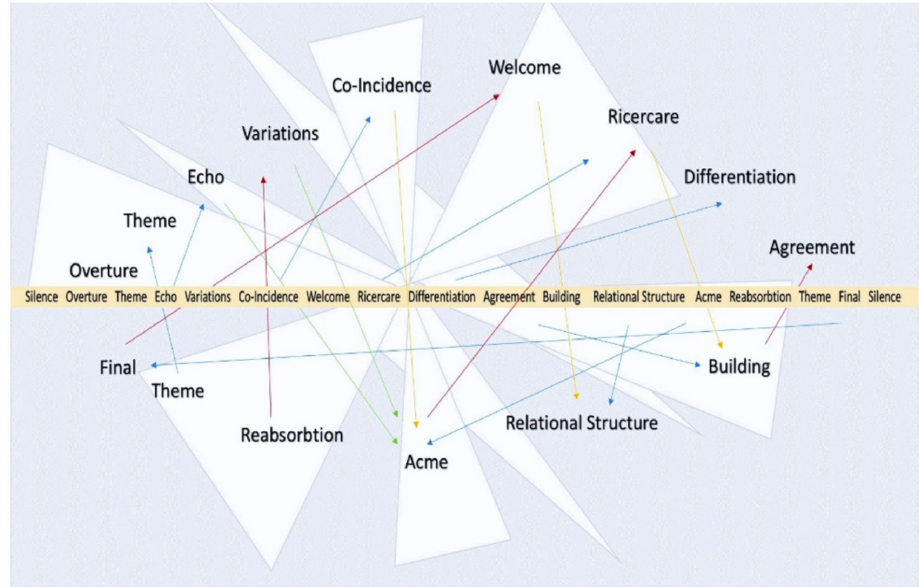
Figure 2. Here the same sequence is indicated as in the previous picture. It is always located in the center but follows a horizontal plane: a different way of showing the same sequence and its reflections that correspond to different levels of perception. The reflections wander in parallel, upwards as well as downwards, ideally suspended for a possible hypothesis of randomness in a three-dimensional way, which gives the performance’s practice the opportunity to preserve the memory of what happened or could happen during the performance. Those arrows in the picture point toward different possibilities to create associations of perception in regard to the different memories of every single moment of expression, corresponding to the different levels of the sequence to be played together, between the different participants on the same precise scene. It is something to be seen as multidimensional, compared to the bi-dimensional one which is Figure